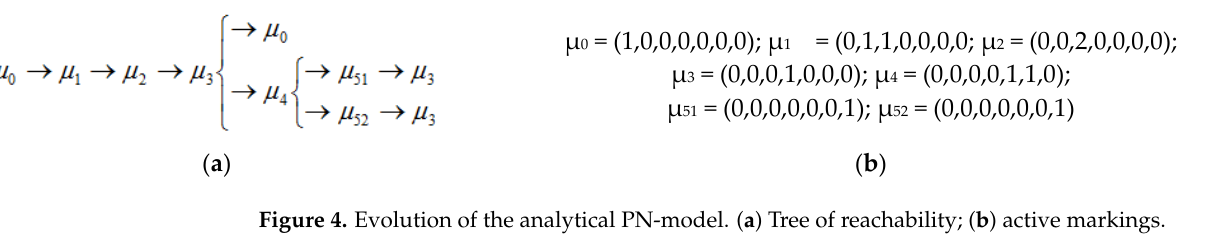
( b ) Figure 3. Definition of the proposed PN-model. ( a ) Analytical definition; ( b ) graph presentation of the PN-model. Transitions (procedures): t 1 /t 2 — identification of incoming request (registered/unreg- istered); t 3 — authentication procedure; t 4 — exit from the system; t 5 — analysis of a legiti- mate request for access; t 6 /t 7 — two types of authorization procedure in reason request for access to external / internal resources; t 8 — end of the current service. Positions (conditions): p 1 — presence of a request for access; p 2 /p 3 — request from un- registered/registered user); p 4 — result after authentication (legitimate or illegitimate ac-